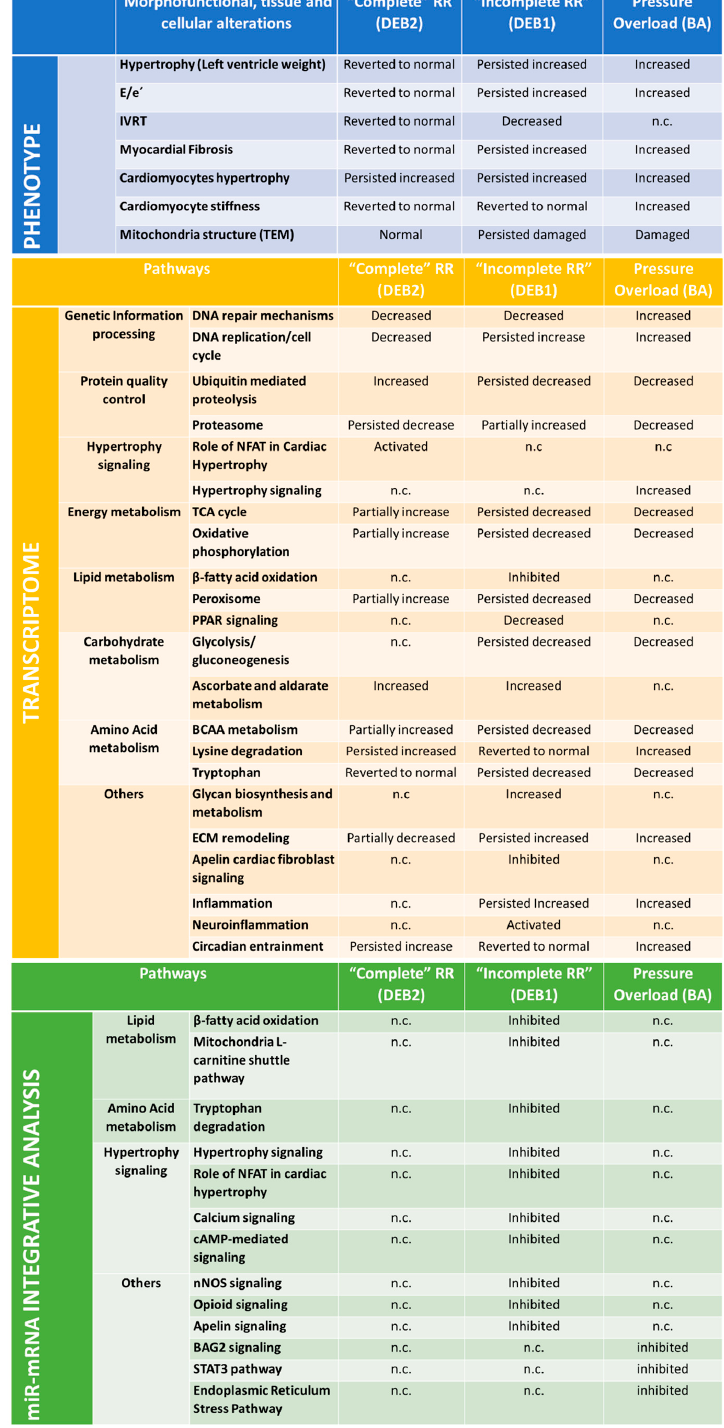
Figure 6. Summary of the most important essential findings after seven weeks of pressure overload (BA group) and after 2 weeks of pressure overload relief (“Incomplete” RR, subgroup DEB1; and “Complete” RR, subgroup DEB2). Table interpretation: ) “Partially” , there was a change in DEB subgroups when compared to BA group but without reverting completely to SHAM values; “Persisted”, modification observed in BA group didn’t revert in DEB subgroups; “Reverted to Normal” , reverted to SHAM values; “Increased” , means that it was exclusively increased in the group; “Decreased” , means it was decreased solely in the group; “n.c.” , no significant or not found dysregulated. IVRT-isovolumetric relaxation